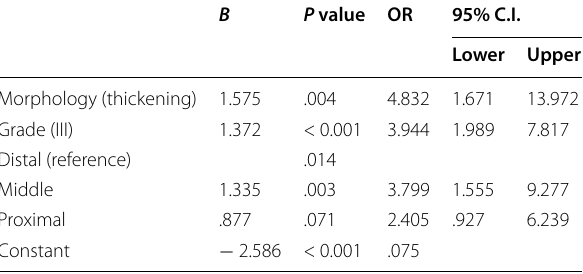
Table 3 Multivariate analysis for independent factors that predict peritoneal metastasis B 95%